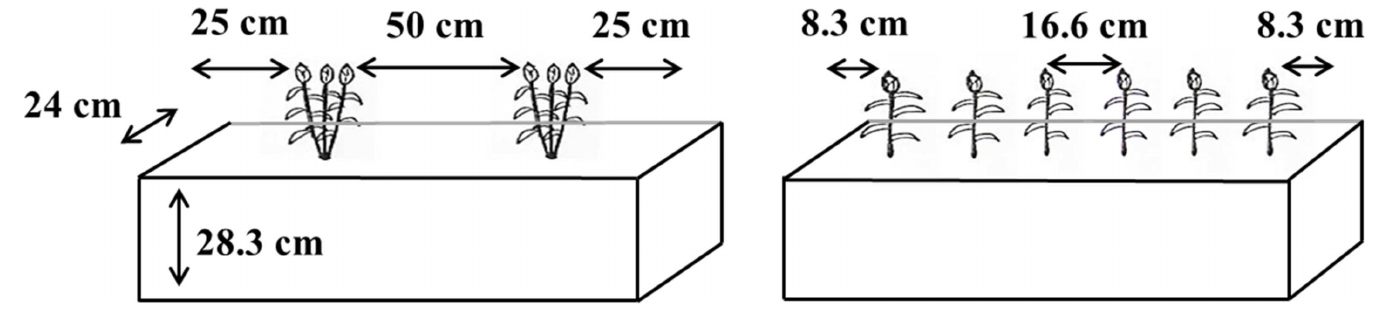
Fig 1. Arrangement of clump (left) and evenly spaced planting (ESP; right) geometries in the wooden